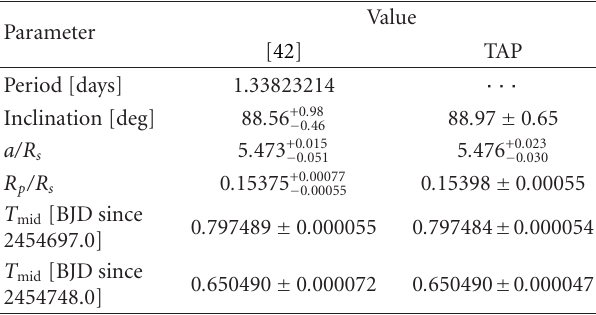
Table 3: Analysis of 2 [42] WASP-4b light